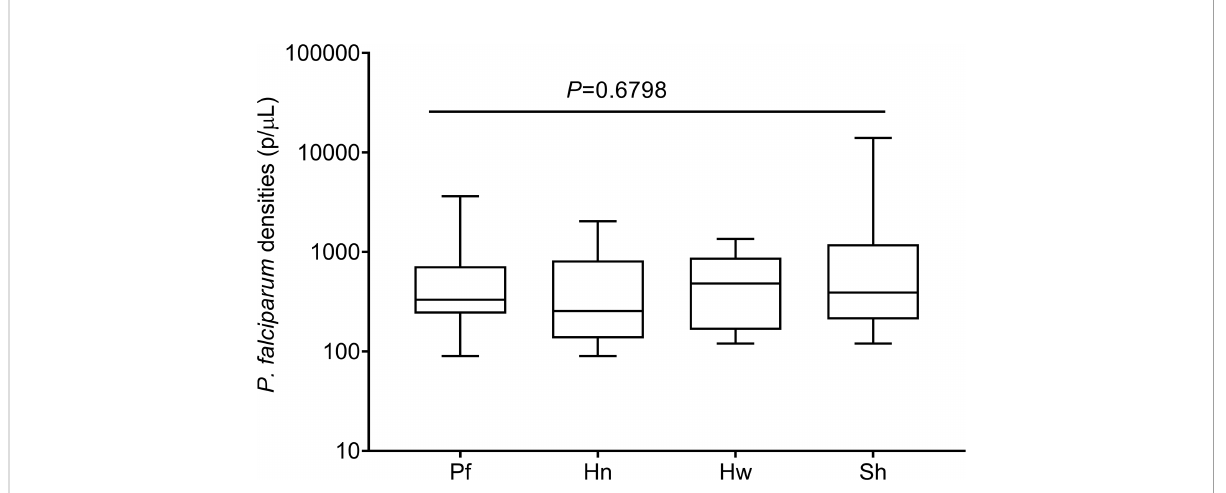
FIGURE 1 Levels of Plasmodium falciparum parasite densities in mono and concomitant infections with helminthic parasites. The data are presented as a box plot with the lower and upper whiskers denoting the lowest and highest P. falciparum densities in each group, respectively. The p-values were generated from Kruskal-Wallis analysis of variance on rank with signi fi cant level set at p <